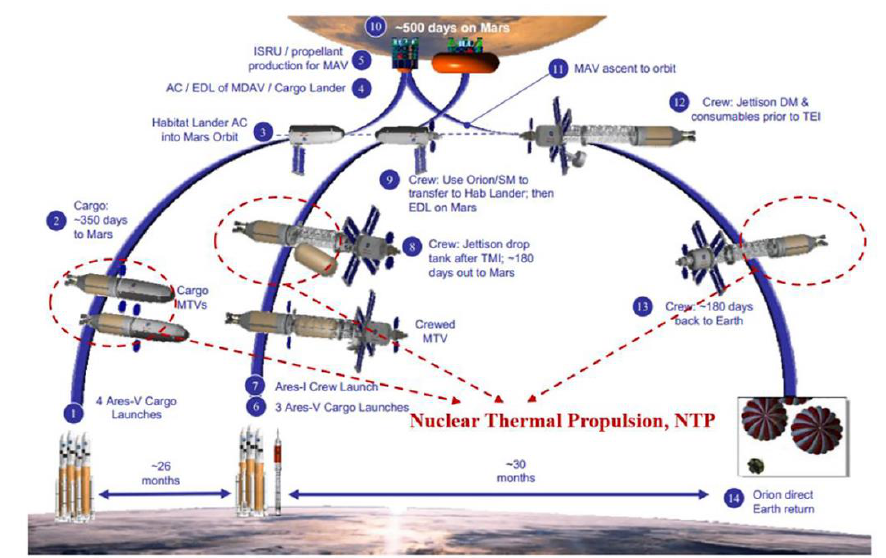
Figure 1. Nuclear thermal propulsion (NTP) reference sequence of a human exploration mission to Mars [11].